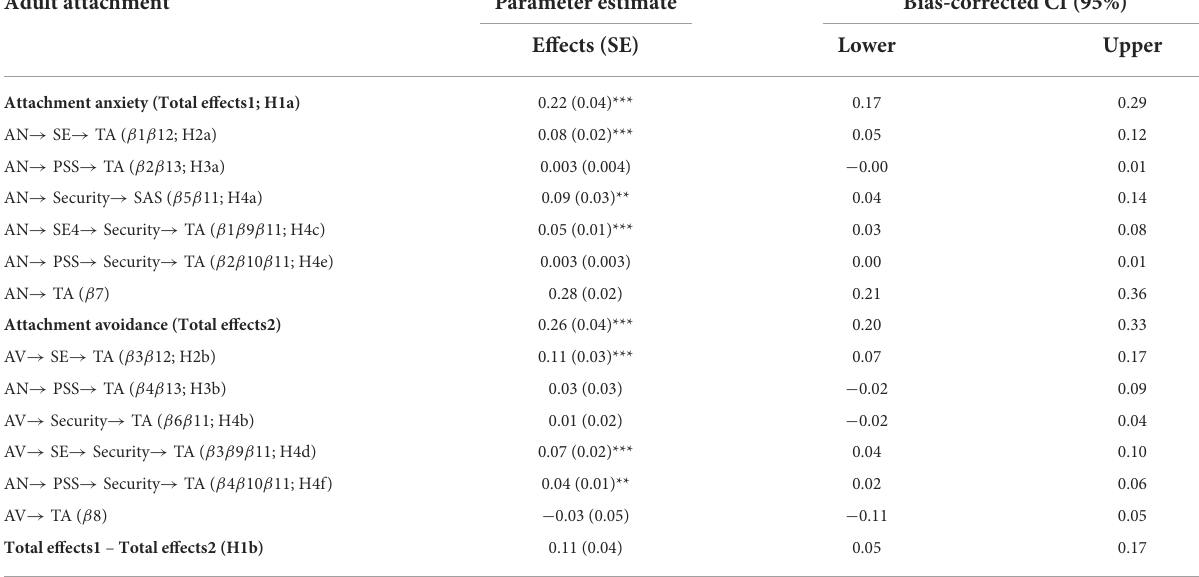
TABLE 2 Direct and indirect effects of adult attachment on trait anxiety. Adult